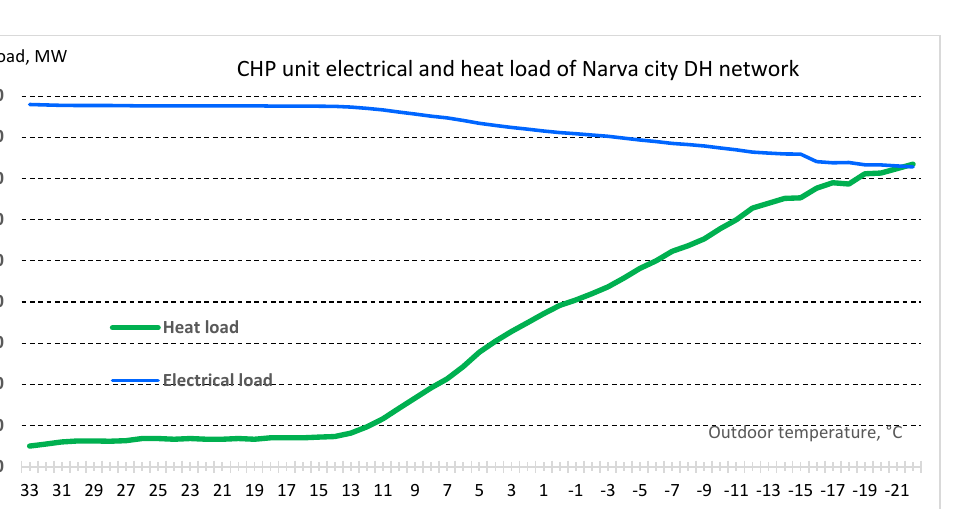
Figure 2. Dependence of the heat demand on the outdoor air temperature.